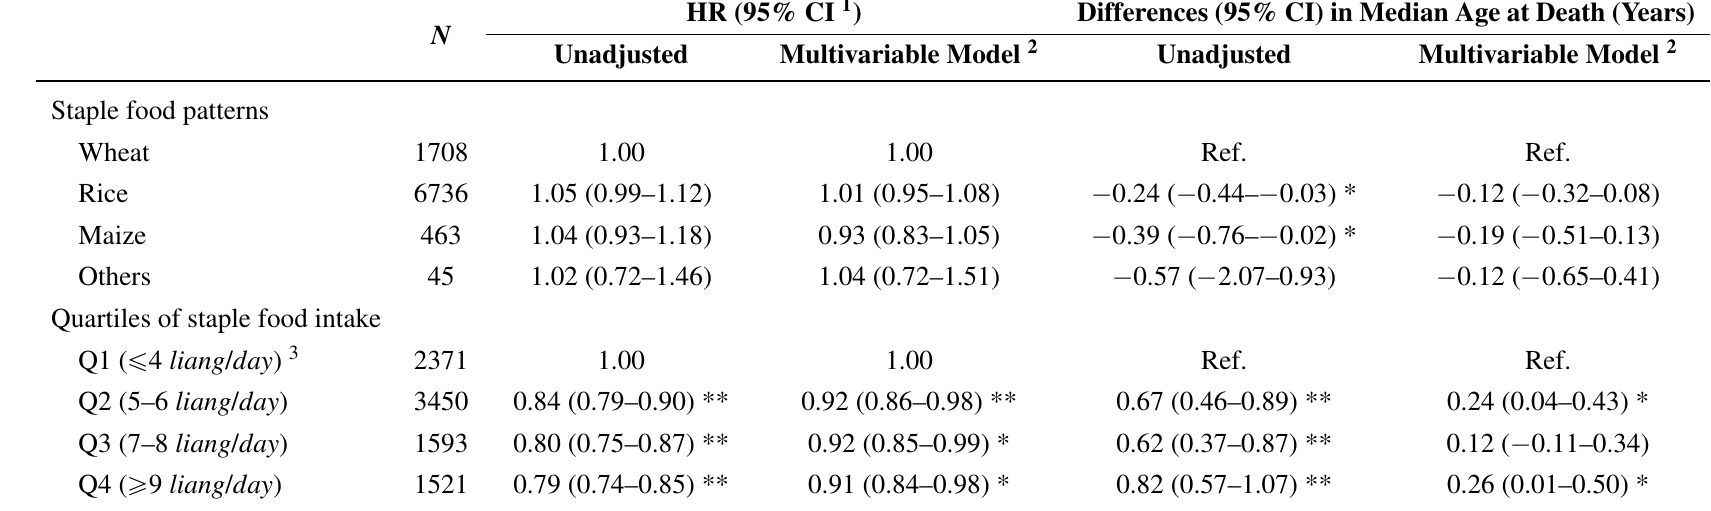
Table 2. Staple food patterns and mortality among Chinese